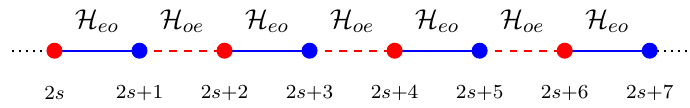
Figure 8 . A section of the alternating bond spin chain for the XY sector. We emphasise the alternating nature by showing the bonds between lattice sites as a dashed line or a thick